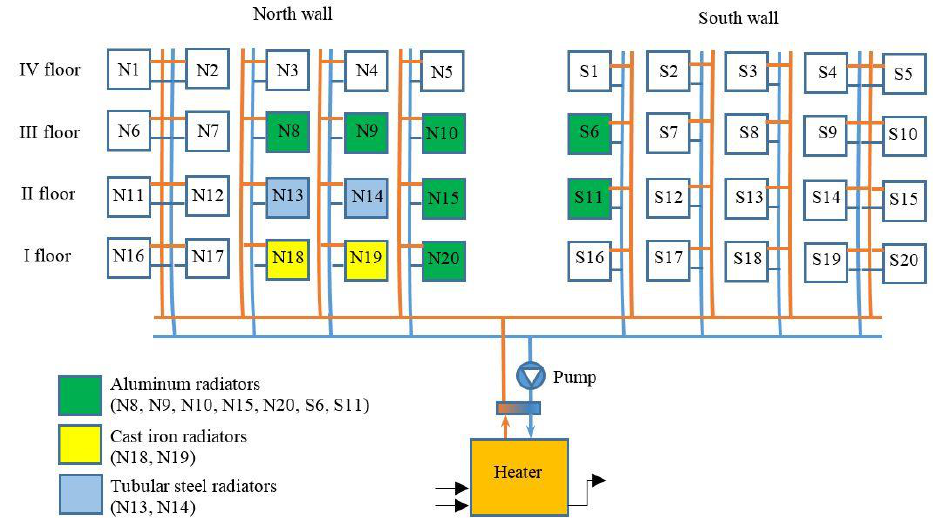
Figure 5. Scheme of the thermal-hydraulic circuit of the INRIM test facility and selected set of water radiators.